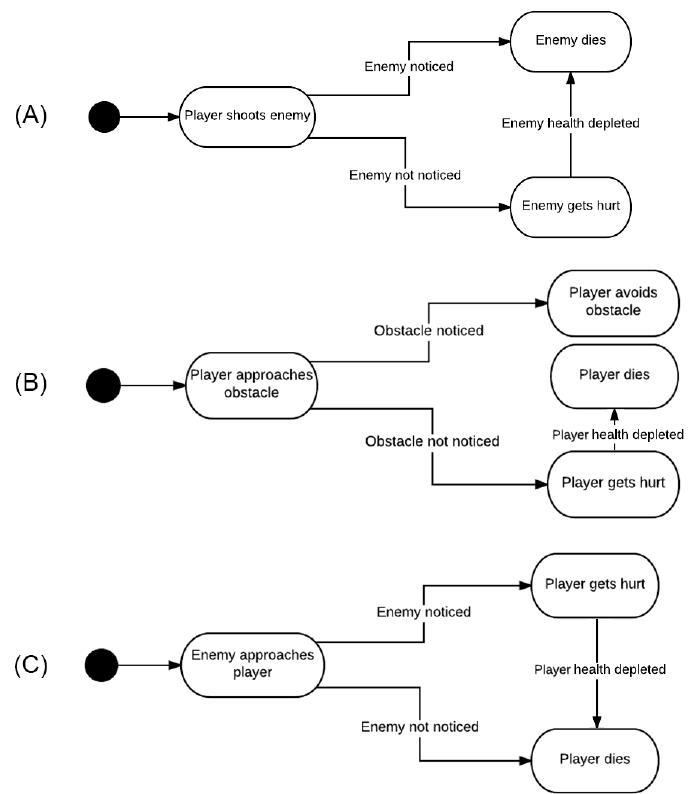
Figure 4. State diagrams for: when the avatar shoots an enemy ( A ); when the avatar approaches an obstacle ( B ); and when an enemy approaches the avatar ( C ). The arrows indicate state transitions and the text in them are the conditions necessary to trigger another state of the